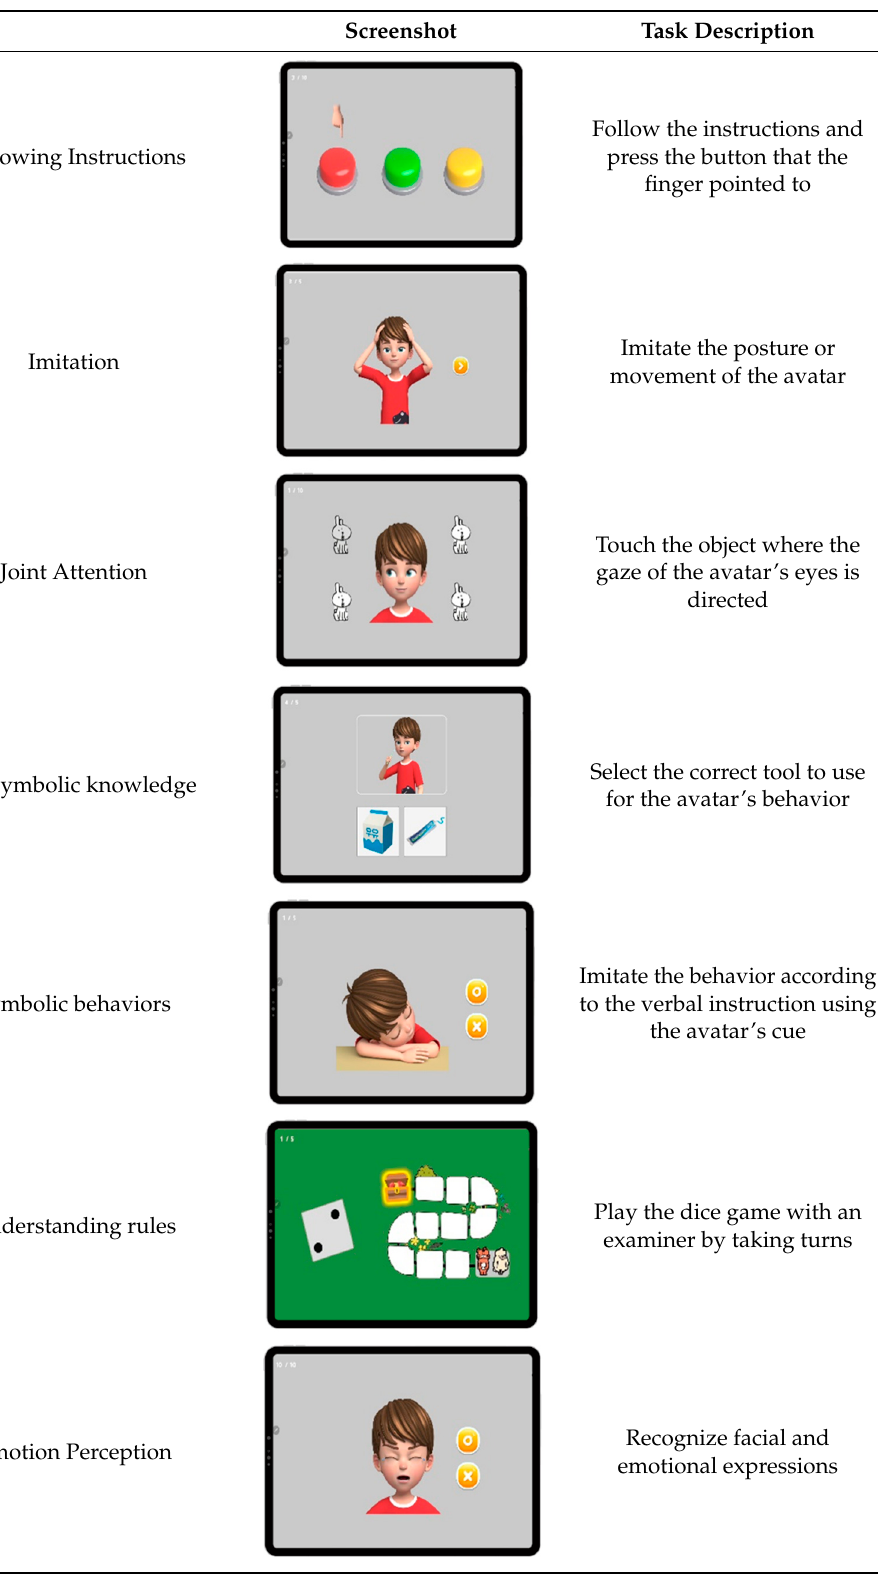
Figure 3. Digital social skills testing using a tablet-based app, patent application 10-2020-0168431 (Republic of Korea, 2022). Table 6. Social skills assessment.